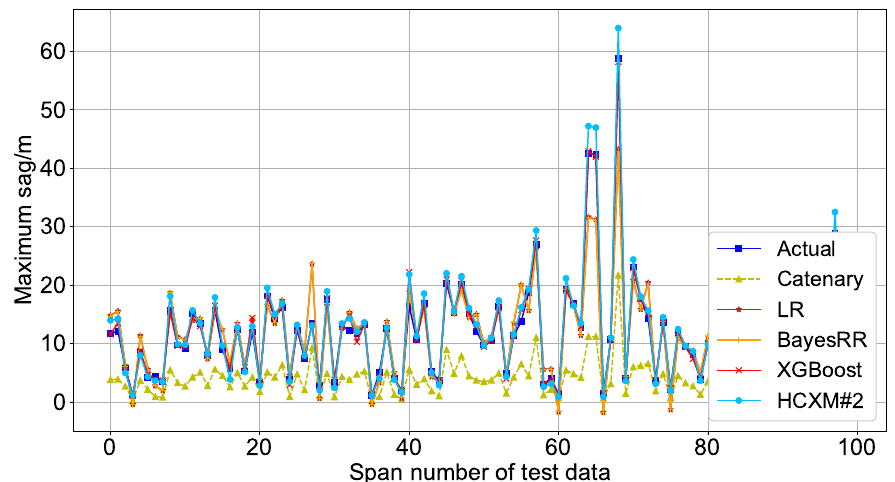
Figure 15. Sag estimation Errors of cluster #1.